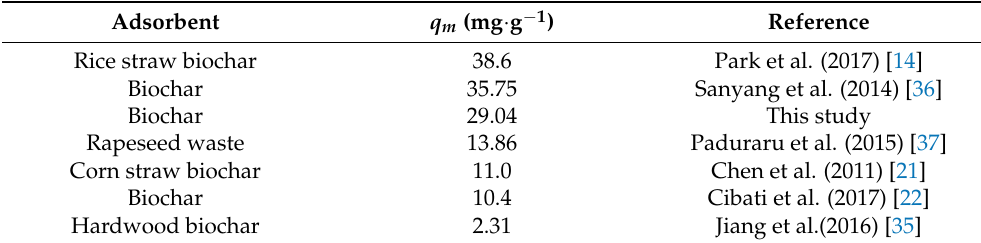
Table 8. Adsorption capacities of different adsorbents towards removal of zinc(II) ions from aqua-